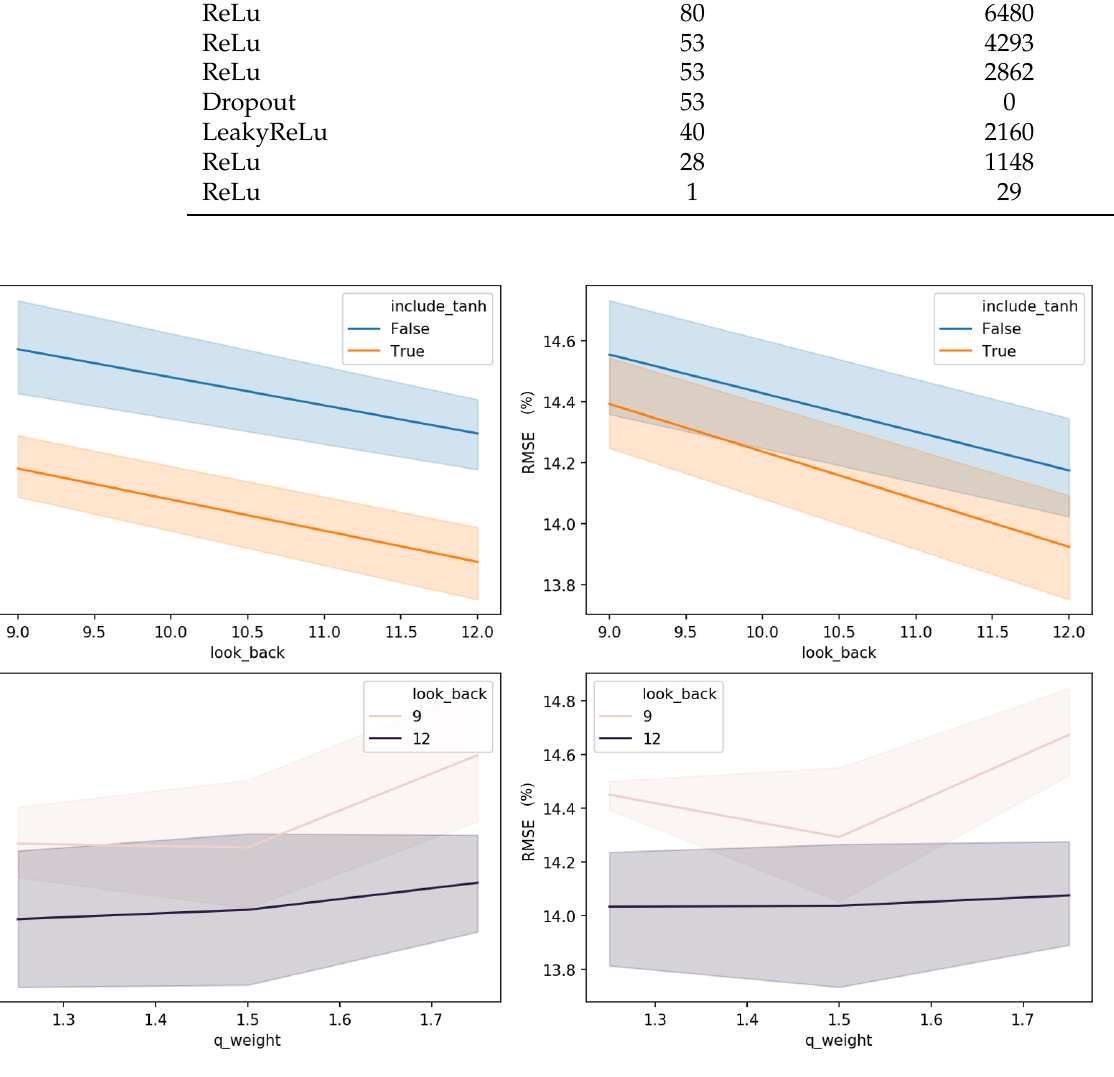
Figure 7. Sensitivity analysis results of the ANN presented in Table 1. This figure shows the optimization process for different parameters such as look_back , which means how many past WRF results are used as inputs to the ANN model; a look_back of twelve would mean that the WRF data from the past two hours are used to predict the electricity production because the WRF output time step is 10 min. The logical variable include_tanh indicates whether or not to include a layer in the ANN with the hyperbolic tangent as activation